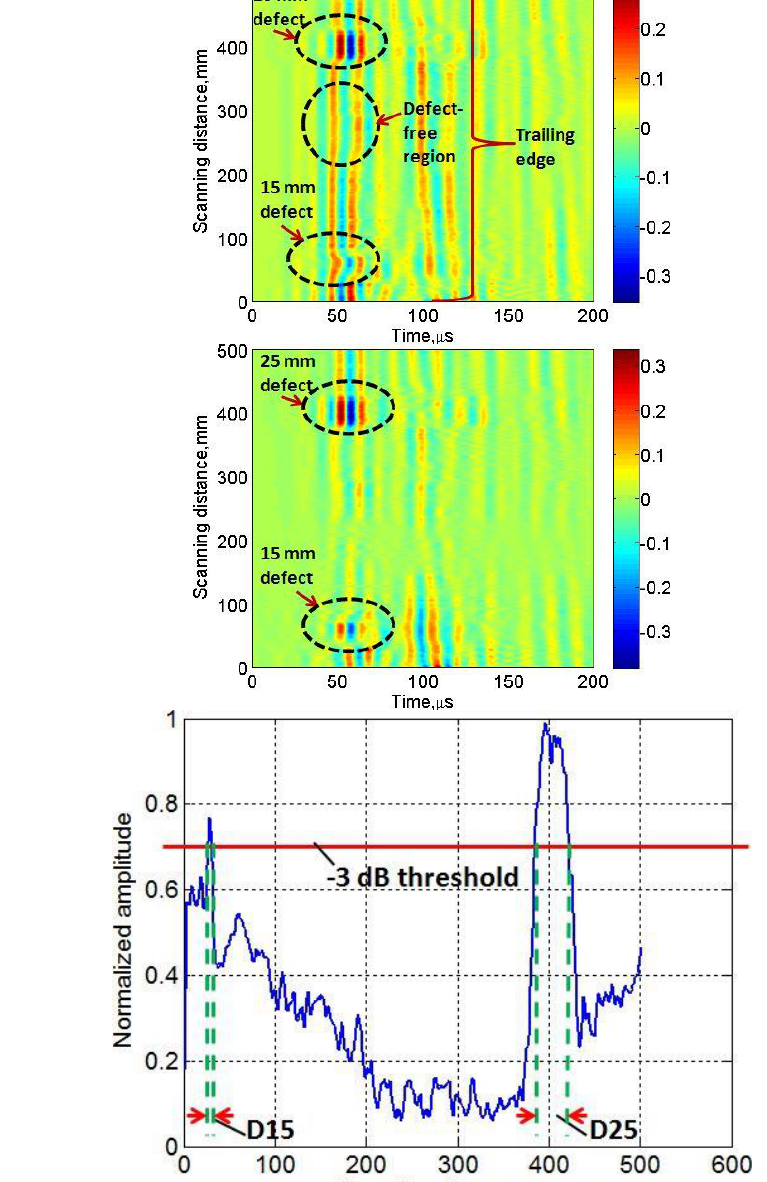
Figure 8. Application of DWT on B-scan signal: ( a ) processed B-scan image by using signals at level-8 by Daubechies wavelet (db16); ( b ) reconstructed B-scan by subtracting the average value (A-scan) of selected defect-free (reference signal); ( c ) detection of both type of defects using amplitude detection by -3 dB threshold (D15 is 15 mm defect and D25 is 25 mm defect).